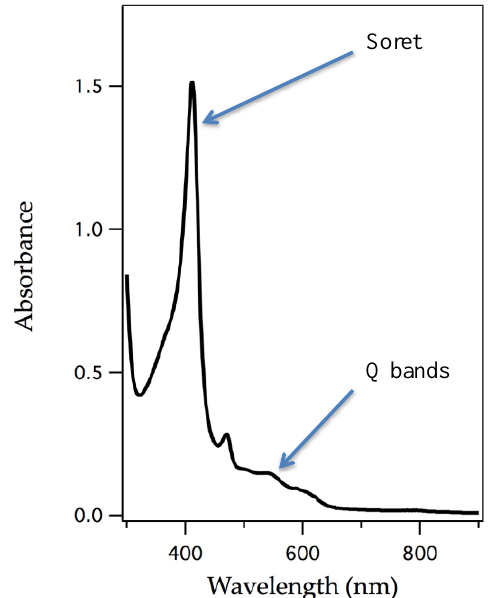
Figure 3. The origin of intensely colored porphyrins arises from its π-conjugated system. A typical UV/vis spectrum of a porphyrin highlighting the π to π* electronic transition called the Soret band and the weaker, Q bands [40].